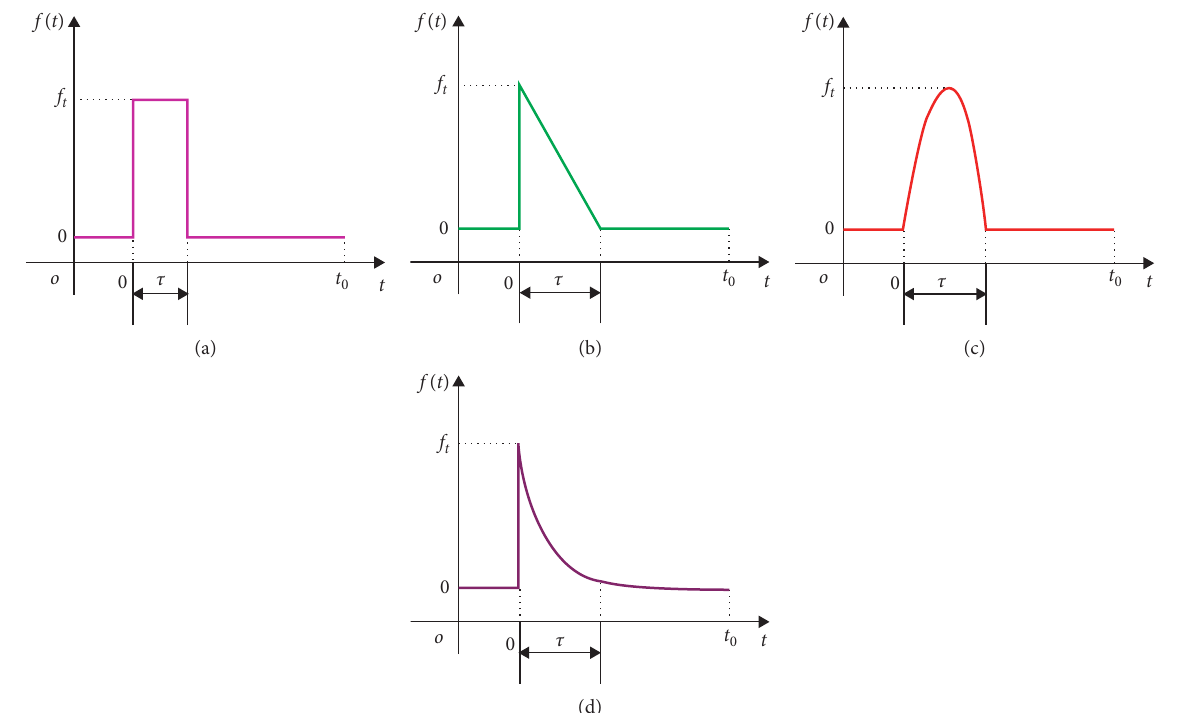
Figure 5: The diagram of load signal. (a) Rectangular pulse signal. (b) Triangular pulse signal. (c) Half-sine pulse signal. (d) Exponential pulse signal.